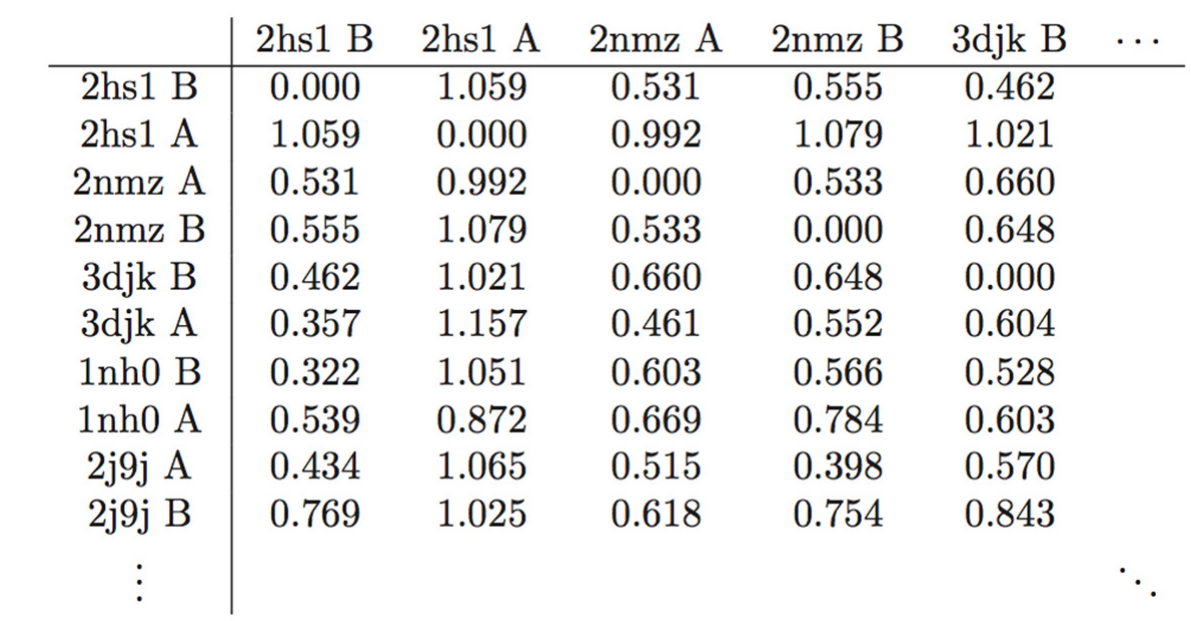
Table 3. Representative table of the pairwise RMSD distance (Å) matrix of the 587 monomers in the study set. Rows and columns are labeled with the PDB ID and chain identifier. This is a